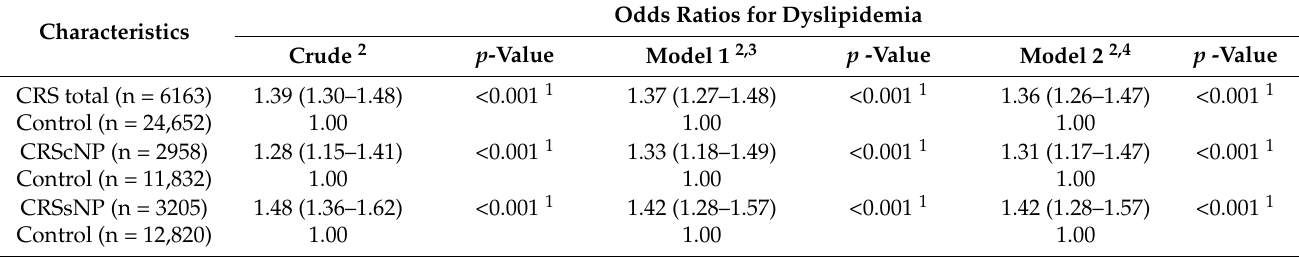
Table 2. Crude and adjusted odds ratios (95% confidence interval) for dyslipidemia in CRS total/CRScNP/CRSsNP groups compared to each control